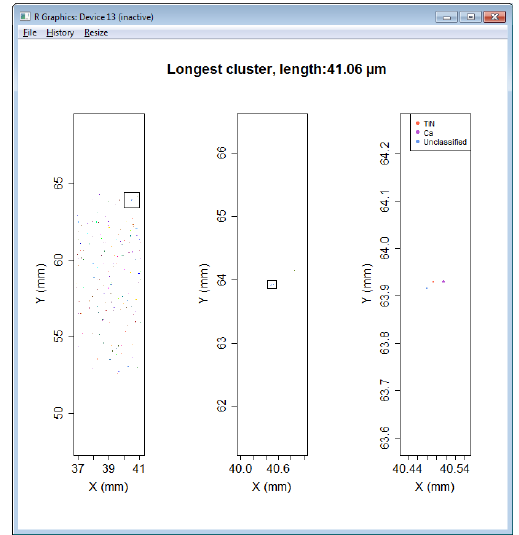
Figure 6: Longest cluster found in the